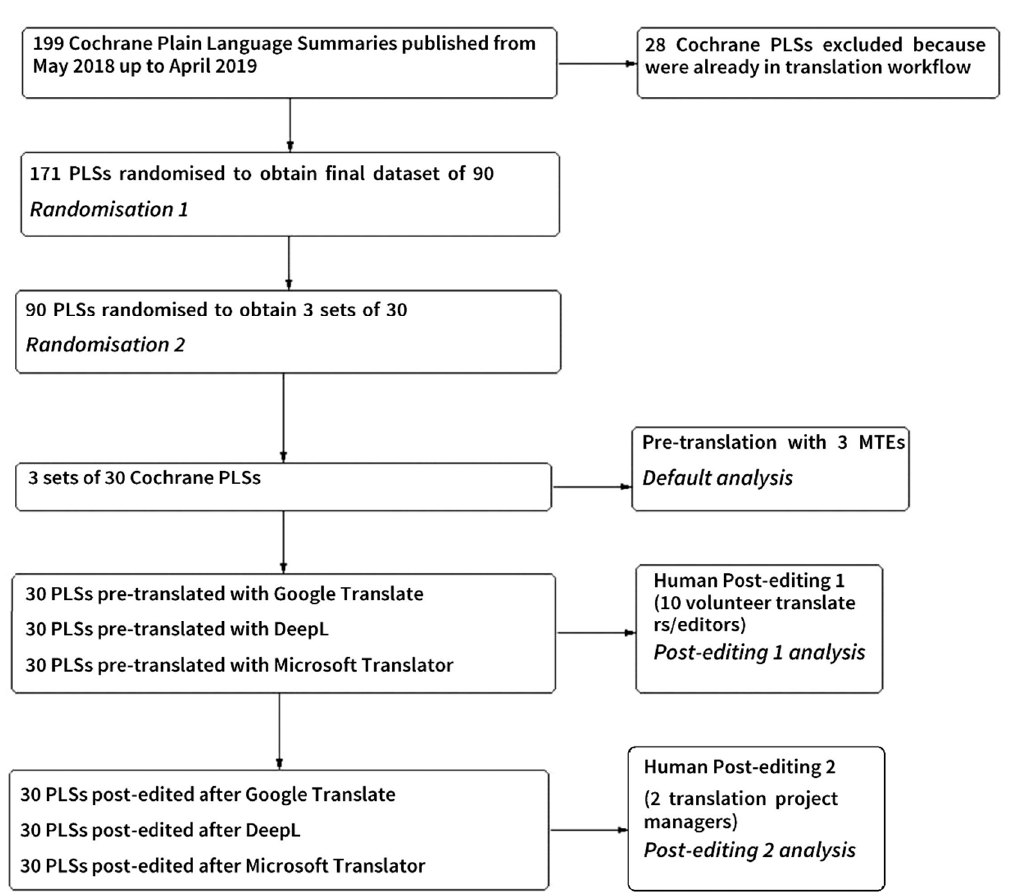
Figure 1. Flow diagram illustrating the different steps of the study. Notes: PLSs—plain language summaries; MTEs— machine translation engines.